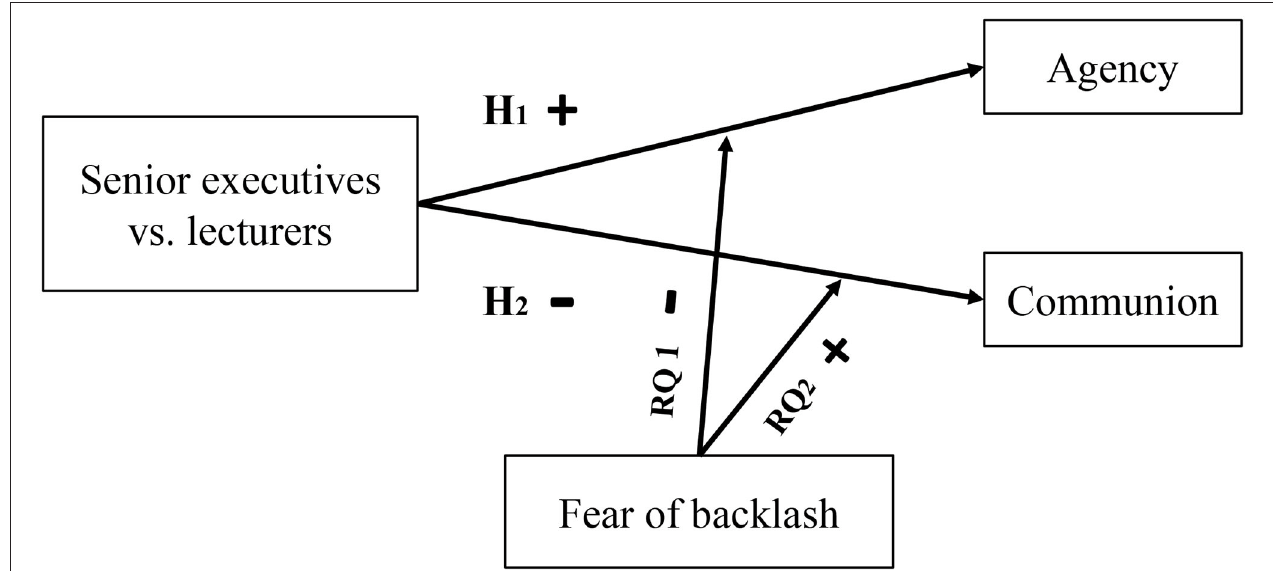
FIGURE 1 | The path of hypotheses and research questions in the theoretical model. The “ + ” represents positive relationship and effect and “ – ” represents negative relationship and